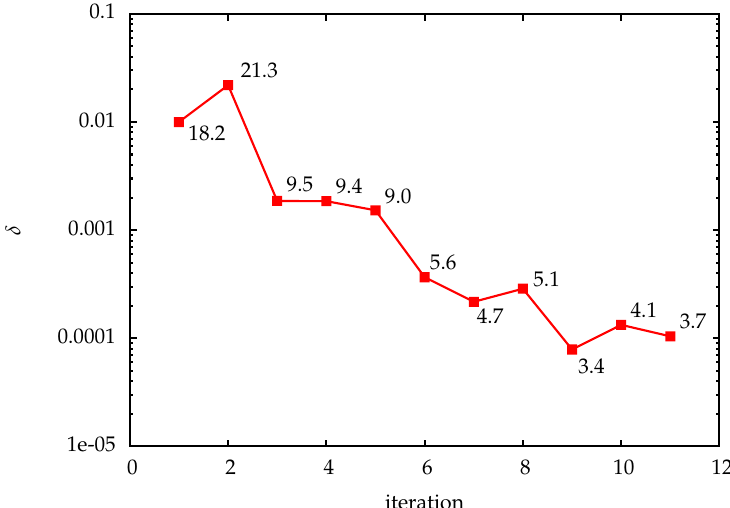
Figure 8. Adaptively chosen quantization tolerances δ and corresponding compression factors for the monodomain example (9), (10) using BFGS. The relatively small adaptive compression factors are due to using worst case error estimates in (11), as well as a fixed maximum mesh